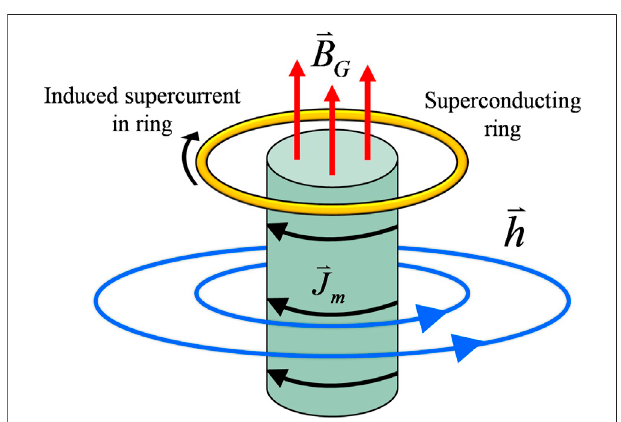
FIGURE1| Arotatingmassivecylindercarriesamasscurrent, (cid:2) J m ,which creates a gravito-vector potential, (cid:2) h , and a corresponding gravito-magnetic (cid:2) h points in the opposite direction of (cid:2) J fi eld, (cid:2) B m as a result of the G . Note that negative sign in ∇ × ( ∇ × (cid:2) h ) (cid:1) − μ G (cid:2) J m . A superconducting ring is coaxial to the cylinder so that a gravito-magnetic fl ux exists through the ring. As the fl ux of (cid:2) B G increases with time, a supercurrent is induced in the superconducting